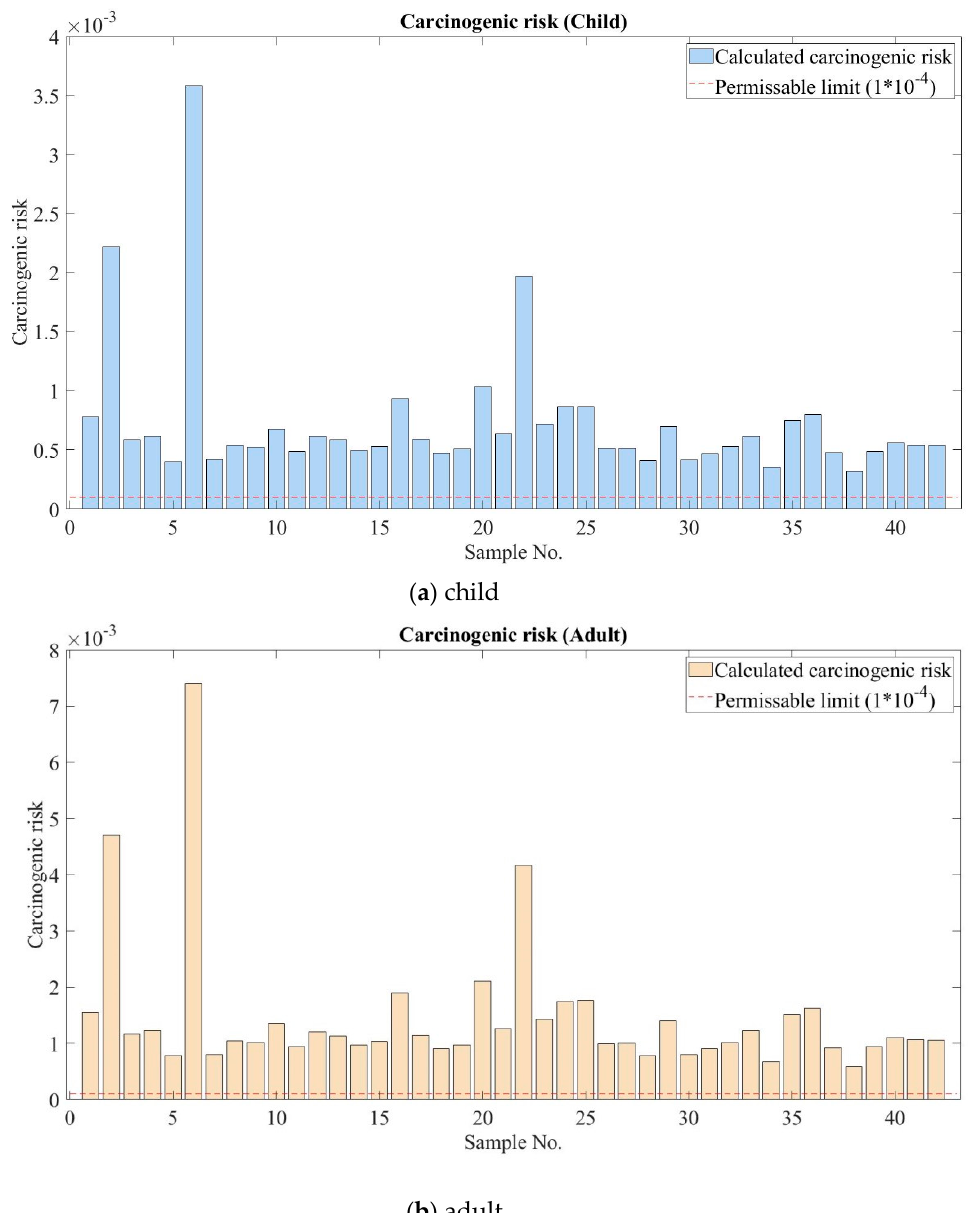
Figure 7. Cancer risk for children and adults living in the ger area.